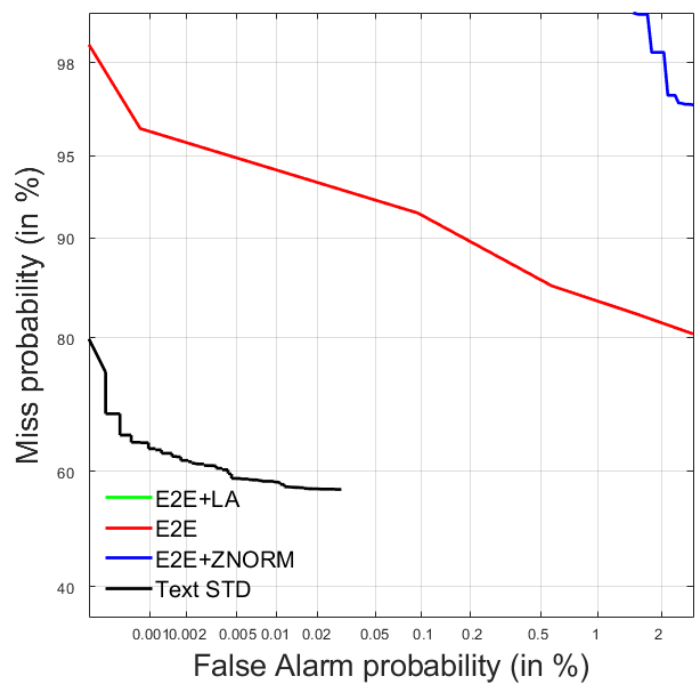
Figure 12. DET curves of the QbE STD systems and the text-based STD system for SPARL20 test data.